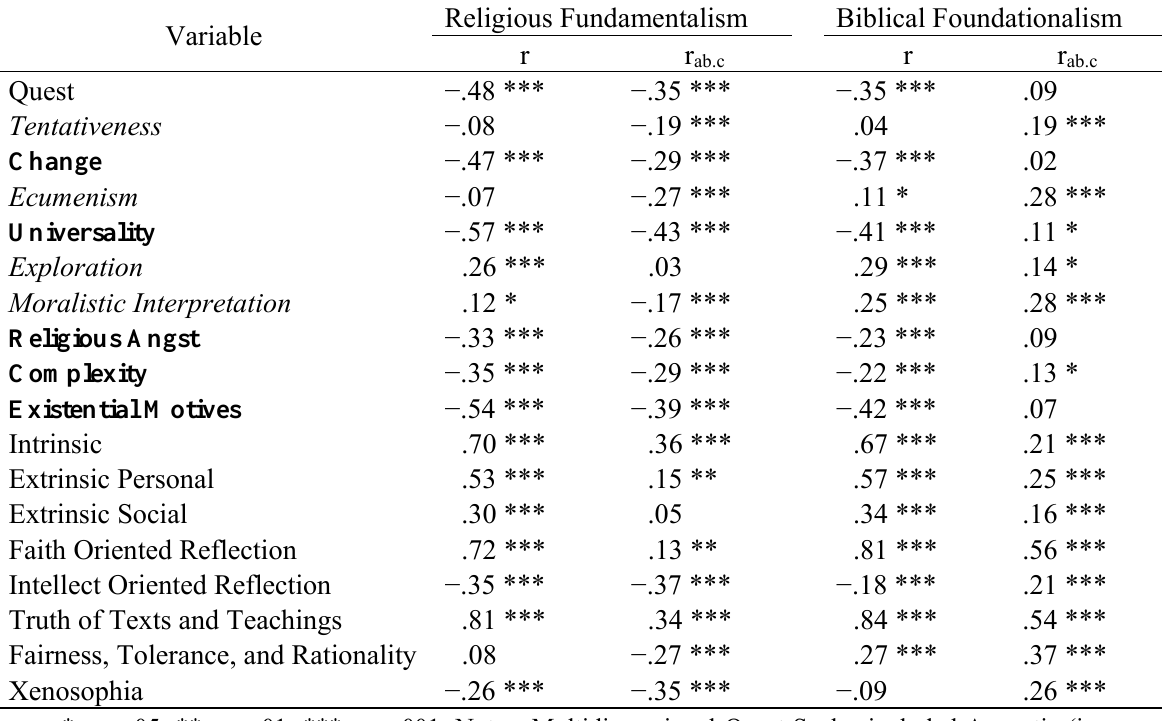
Table 3. Zero-Order (r) and Partial (r Biblical Foundationalism with Other Measures